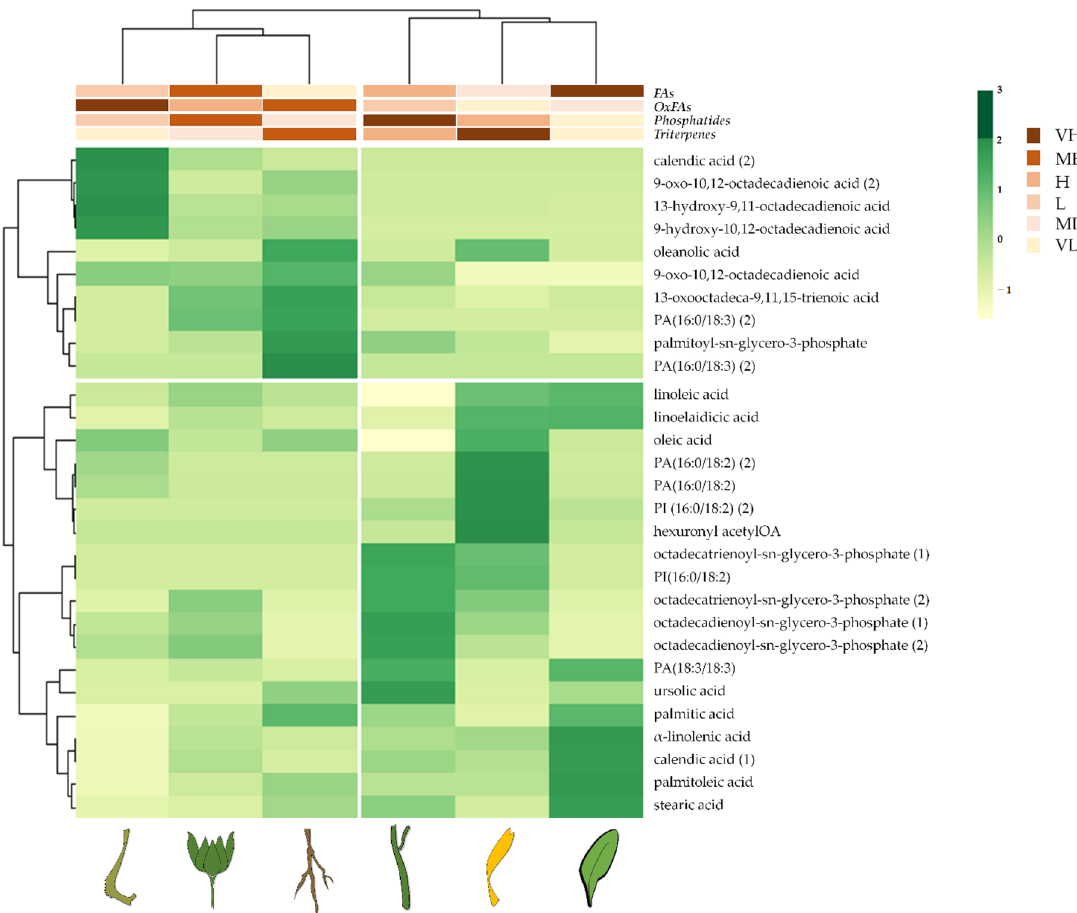
Figure 4. Heatmap of all compounds putatively in n -hexane extracts from Calendula arvensis organs. On the top, clustering of Fas, oxylipins (OxFAs), phosphatides, and triterpenes are shown. VH: very high; MH: medium high; H: high; L: low; ML: medium low; VL: very